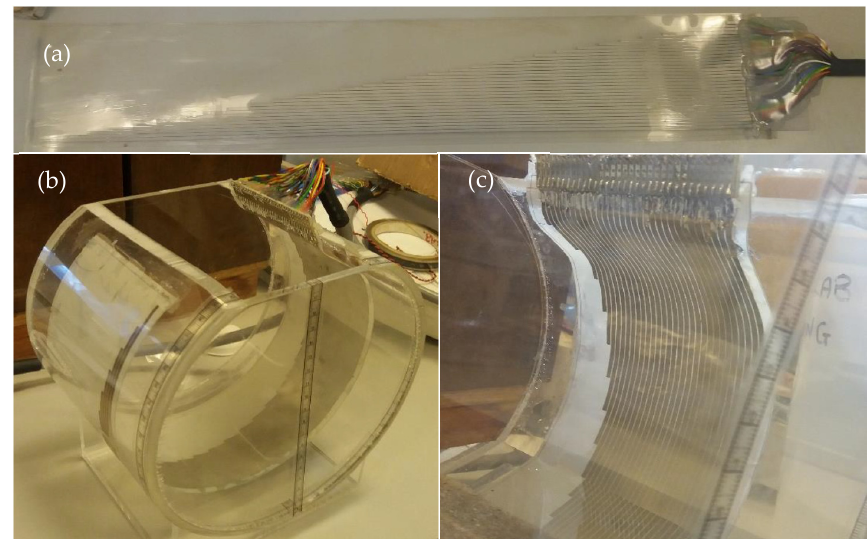
Figure 5. Configuration of sensor and circular pipe used for the experiments: ( a ) the sensor; ( b ) the experiment configuration; ( c ) the sensor attached to the pipe’s inner wall.